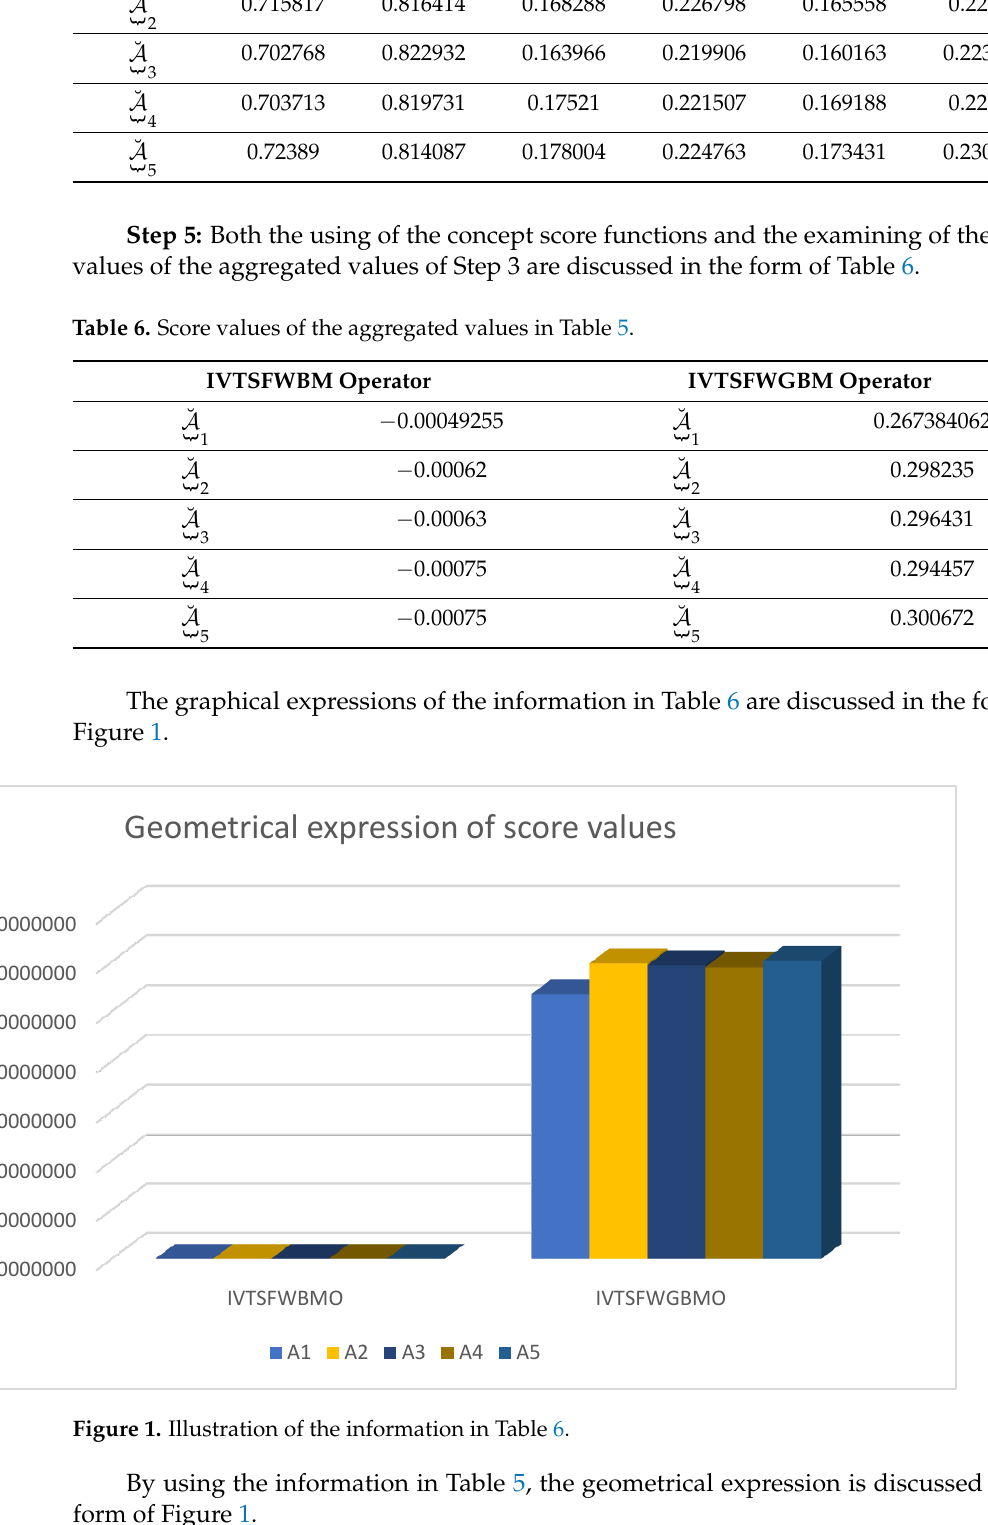
Table 7. Ranking values of the score values in Table 6 .